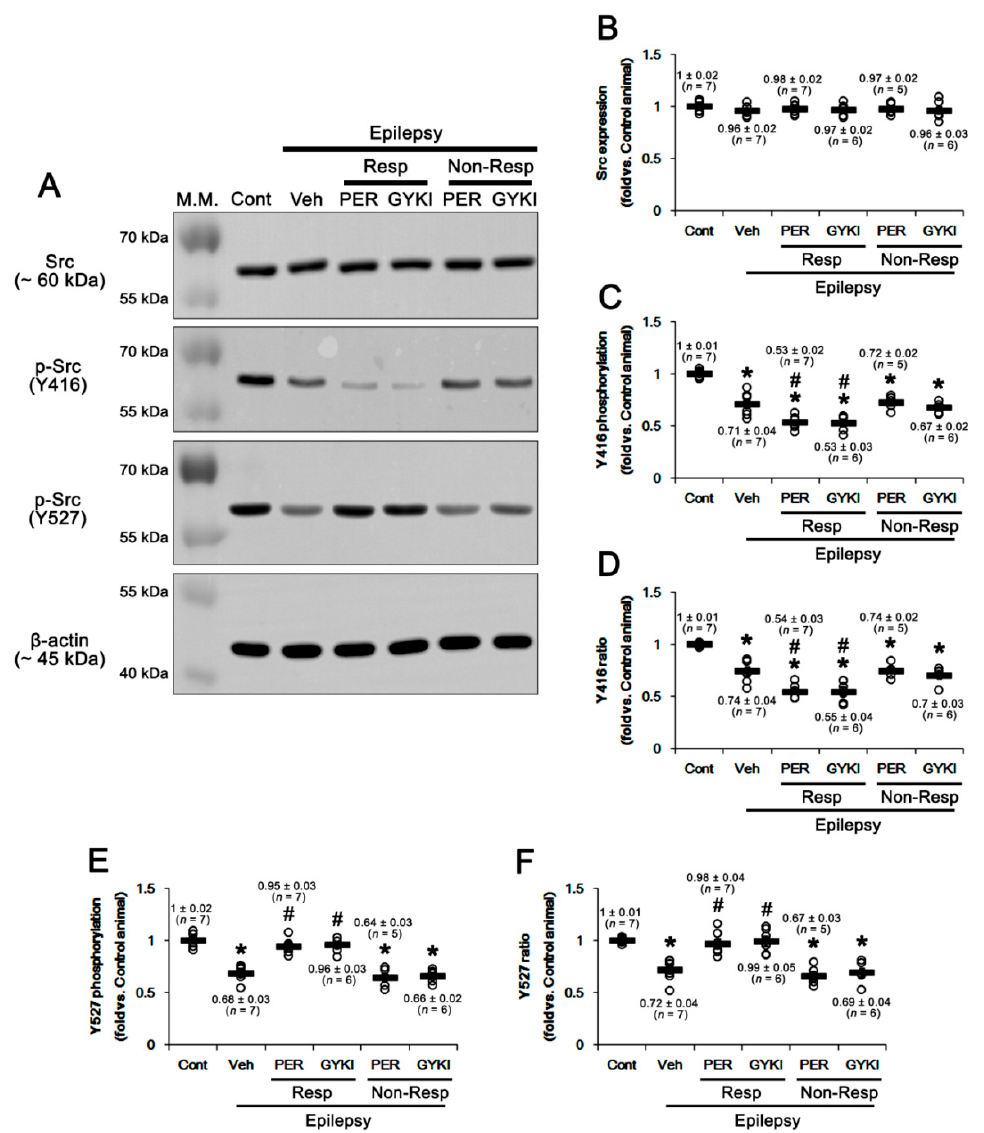
Figure 5. The e ff ects of perampanel (PER) and GYKI 52,466 (GYKI) on total Src family (Src) and its Y416 and Y527 phosphorylations in chronic epilepsy rats. Both AMPAR antagonists reduce Src Y416 phosphorylation in responders (Resp), but not non-responders (Non-Resp), while they increase Src Y527 phosphorylation only in responders. ( A ) Representative images for Western blot of CK2 and p-CK2 levels in the hippocampal tissues. ( B – F ) Quantifications of Src ( B ), p-Src Y416 ( C ), p-Src Y416 / Src ratio ( D ), p-Src Y527 ( E ), and p-Src Y527 / Src ratio ( F ) levels in the hippocampal tissues. Open circles indicate each individual value. Horizontal bars indicate mean value. Error bars indicate SEM ( * , # p < 0.05 vs. control and vehicle (Veh)-treated animals, respectively; one-way ANOVA with post hoc Bonferroni’s multiple comparison).